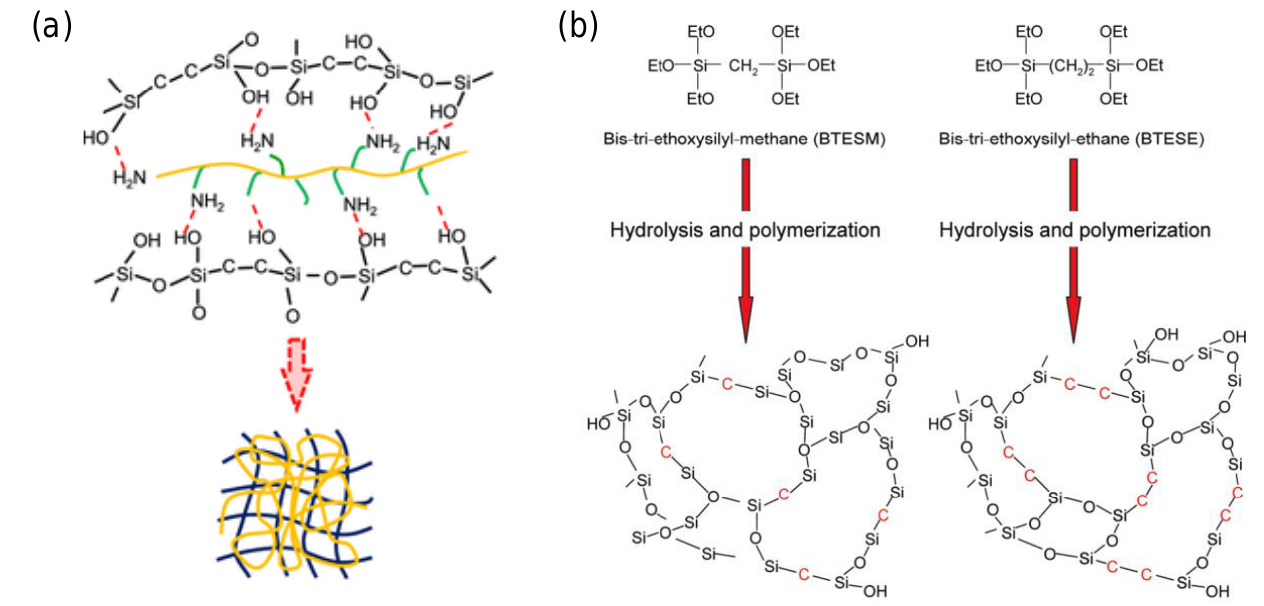
Figure 5. ( a ) Schematic image of organosilica-derived-polymer dual interpenetrating network (IPN). ( b ) Schematic images of amorphous organosilica networks derived from bis(triethoxysilyl)methane and bis(triethoxysilyl)ethane. ( a , b ) reproduced from [59,61],